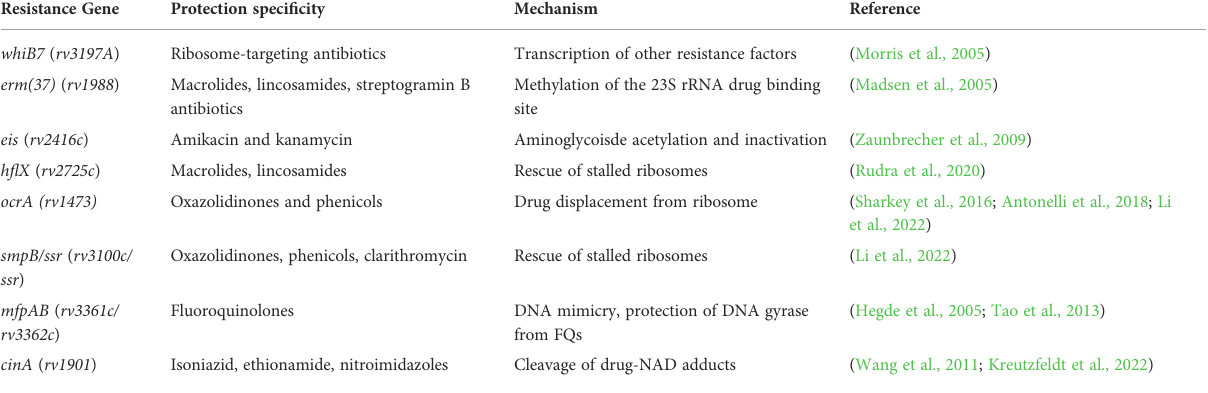
TABLE 1 Cytosolic intrinsic drug resistance factors of